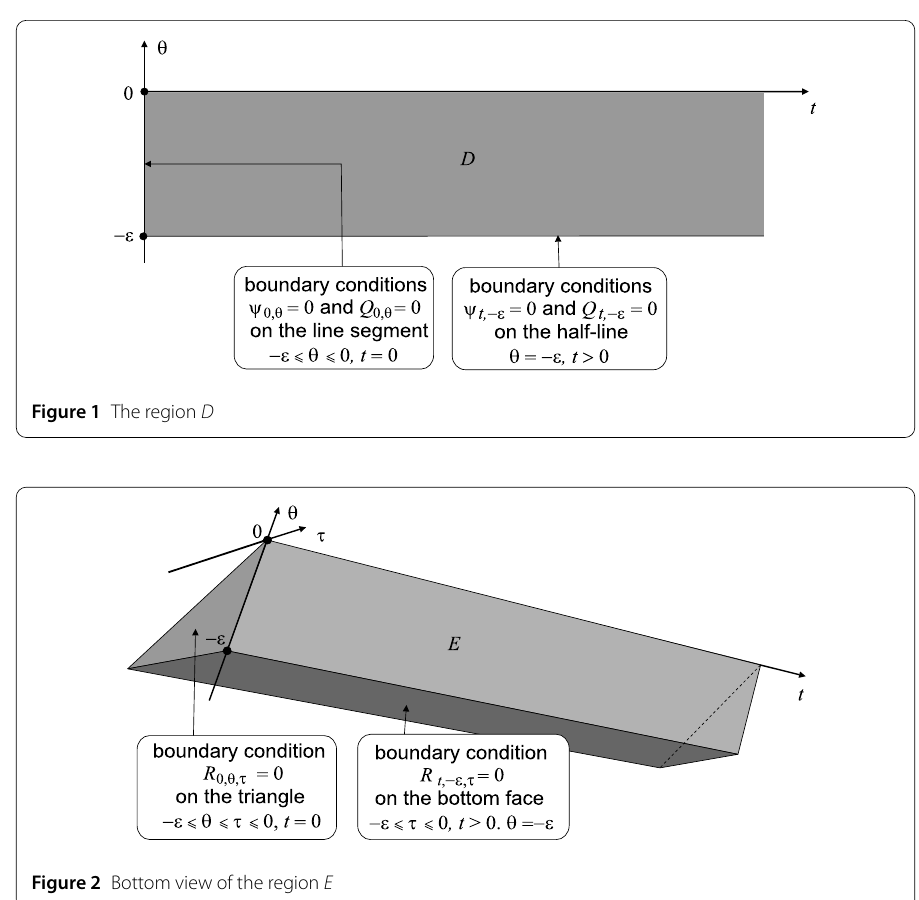
Figure 2 Bottom view of the region